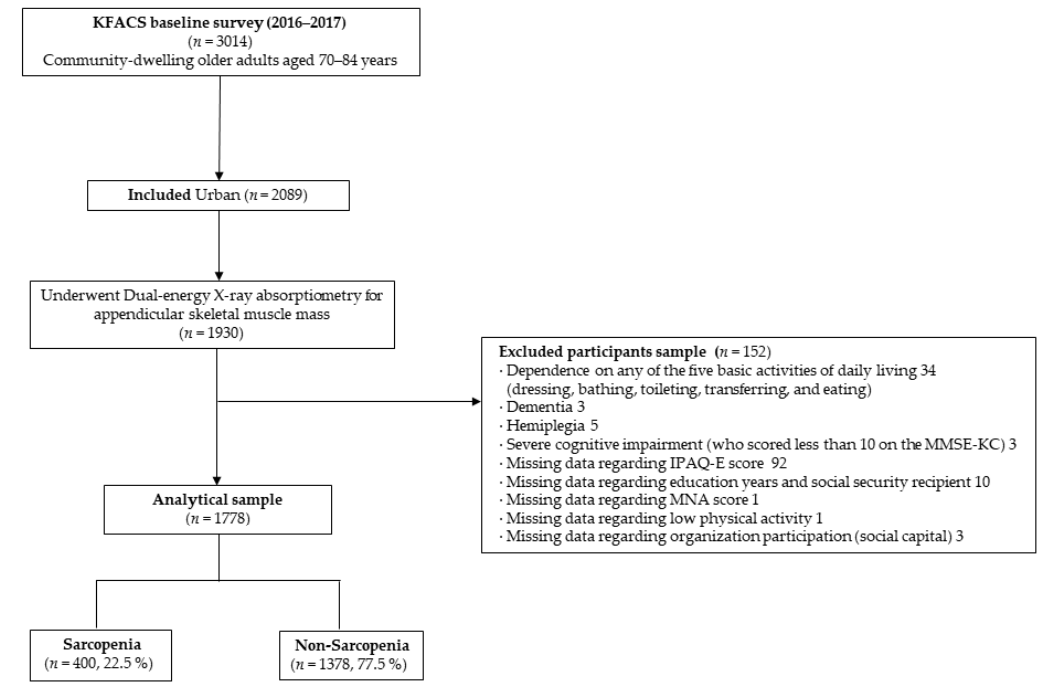
Figure 1. Flow chart of the study population.